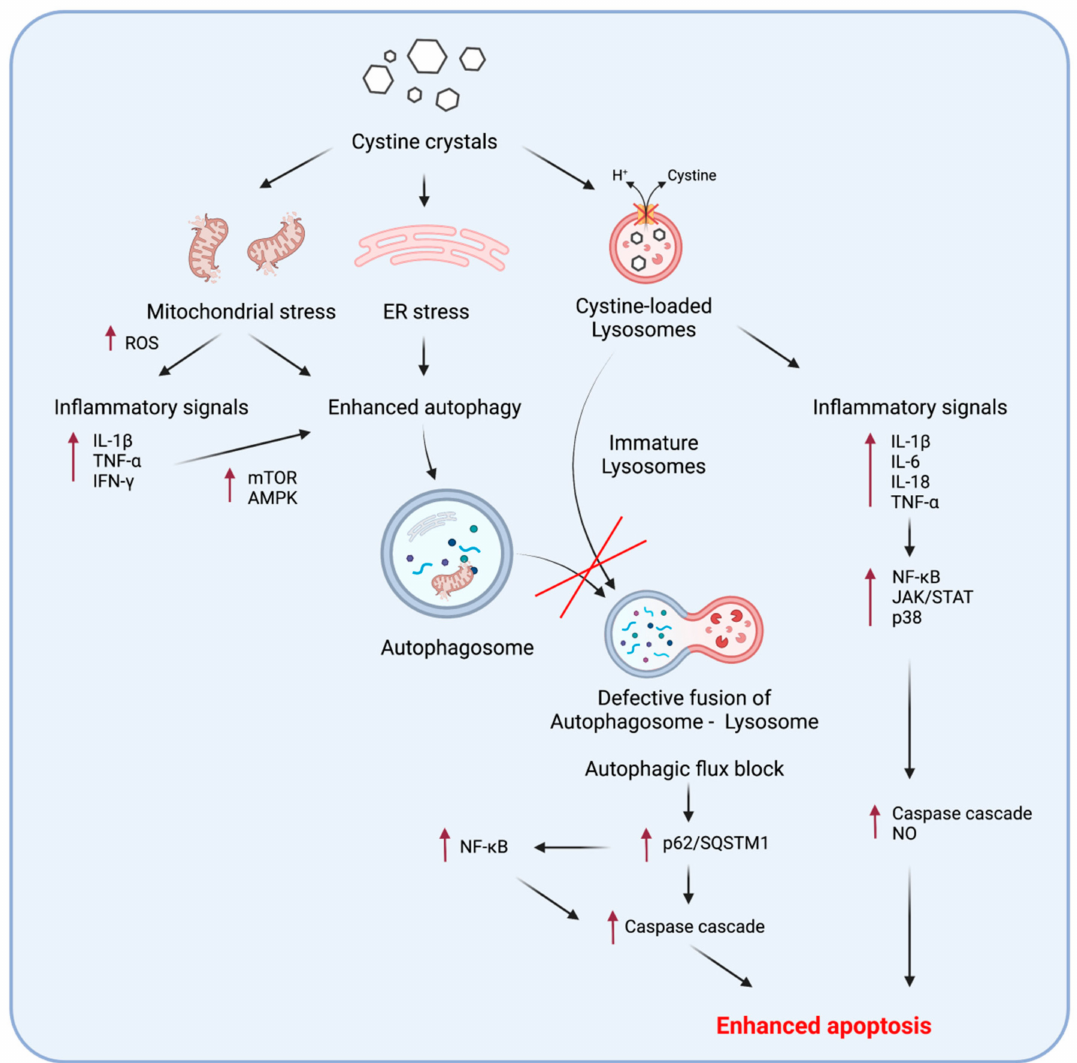
Figure 3. The interplay of inflammation, autophagy, and apoptosis in nephropathic cystinosis cells. A schematic representation of the effects of cystine crystals leading to the disturbance of inflamma- tory, autophagy, and apoptotic signals, and the disturbance of the crosstalk between these pathways. AMPK, AMP-activated protein kinase; INF- γ , interferon- γ ; IL, interleukin; JAK/STAT, Januski- nase/signaltransducerandactivatoroftranscription; mTOR, mammalian target of rapamycin;NF- κ B, nuclear factor kappa light chain enhancerof activated B cells; NO, nitric oxide; p38, p38 mitogen activated protein kinase; p62/SQSTM1, Sequestosome-1; ROS, reactive oxygen species; TNF- α , tumor necrosis factor- α